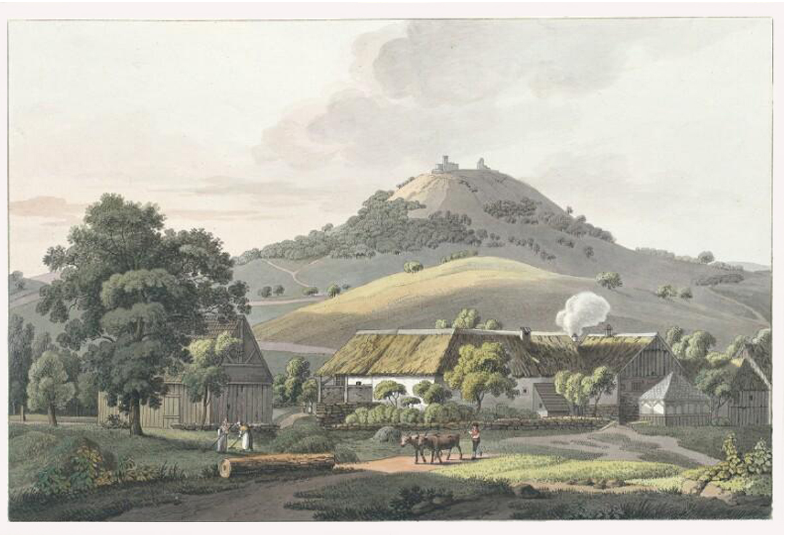
Figure 40. Simon Petrus Klotz after Lorenz Janscha. A View of Geyersberg near Töplitz in Bohemia , early